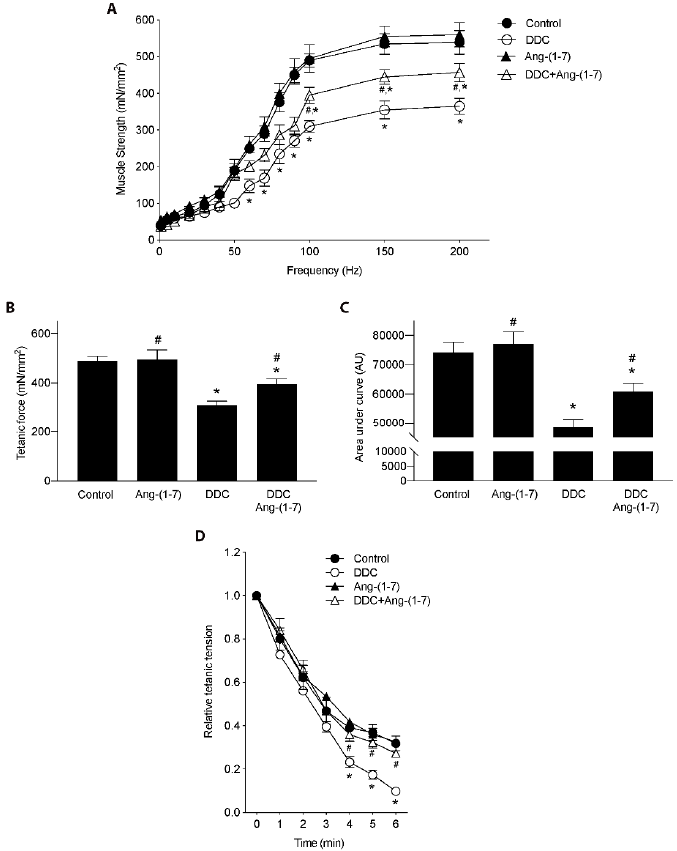
Figure 2. Preventive effect of Ang-(1-7) on the decrease of muscle strength and fatigue induced by DDC diet in gastrocnemius muscle of mice. Male mice C57BL/6J (16 weeks old) were randomly separated into four groups: Control, Ang-(1-7), DDC, and DDC + Ang-(1-7). DDC was administrated by diet for six weeks, whereas Ang-(1-7) was administered through osmotic minipumps for six weeks. Five or six animals per group were used for three independent experiments. At the end of the experiment, gastrocnemius muscle was excised, and electrophysiological assays were performed. ( A ) Muscle strength was measured at different frequencies and represented as mN/mm 2 . (* p < 0.05 vs. Control; # p < vs. DDC. Two-way ANOVA, Dunnett’s multiple comparisons test). ( B ) Maximal tetanic force in mN/mm 2 . (* p < 0.05 vs. Control; # p < vs. DDC. One-way ANOVA, Tukey’s multiple comparisons test). ( C ) Muscle strength represented as area under each curve of experiments showed in A. (* p < 0.05 vs. Control; # p < vs. DDC. One-way ANOVA, Tukey’s multiple comparisons test). ( D ) Fatigue was evaluated as tension relative to tetanic tension for six min. Values are expressed as mean ± SEM. (* p < 0.05 vs. Control; # p < vs. DDC. Two-way ANOVA, Dunnett’s multiple comparisons test).